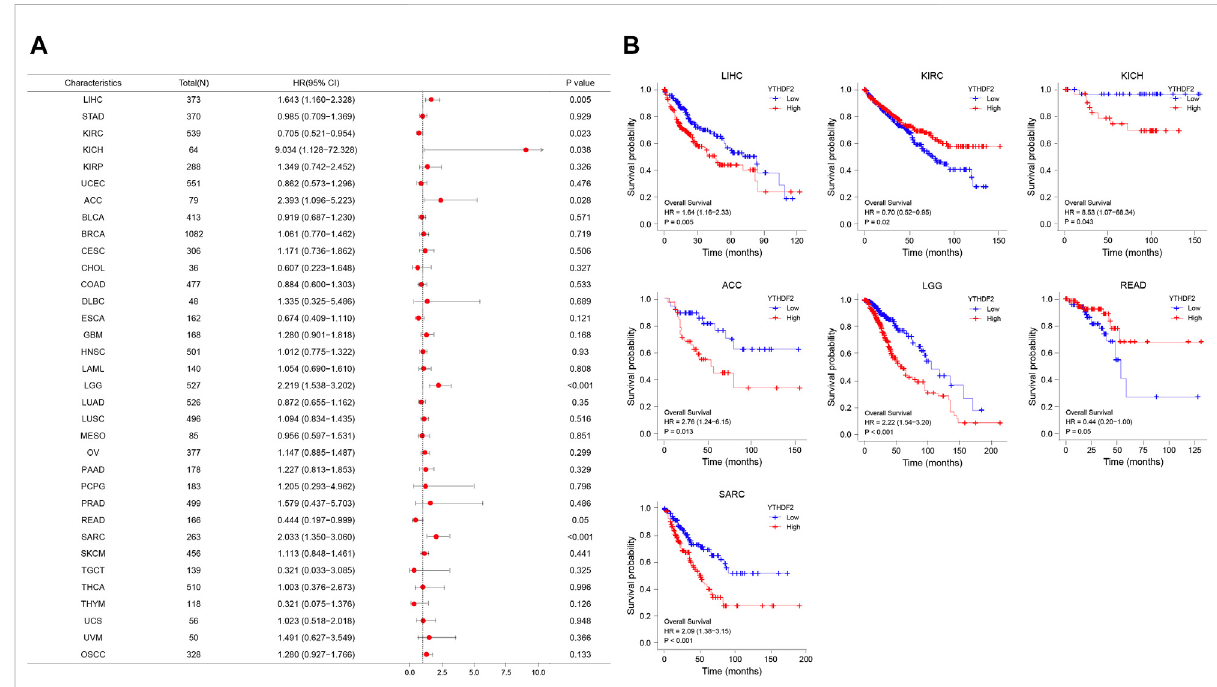
FIGURE 3 YTHDF2 expression is associated with overall survival time (OS). (A) Forest plot of OS associations in 34 cancer types. (B) Kaplan-Meier analysis of the association between YTHDF2 expression and